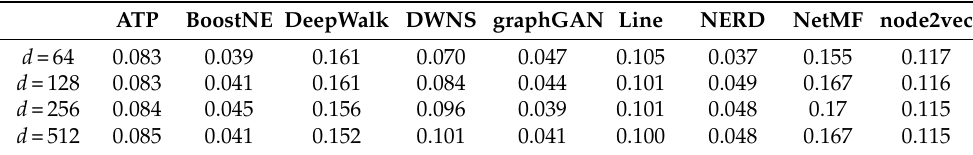
Table A1. Precision values of all embedding methods with the BlogCatalog dataset and different values of d .